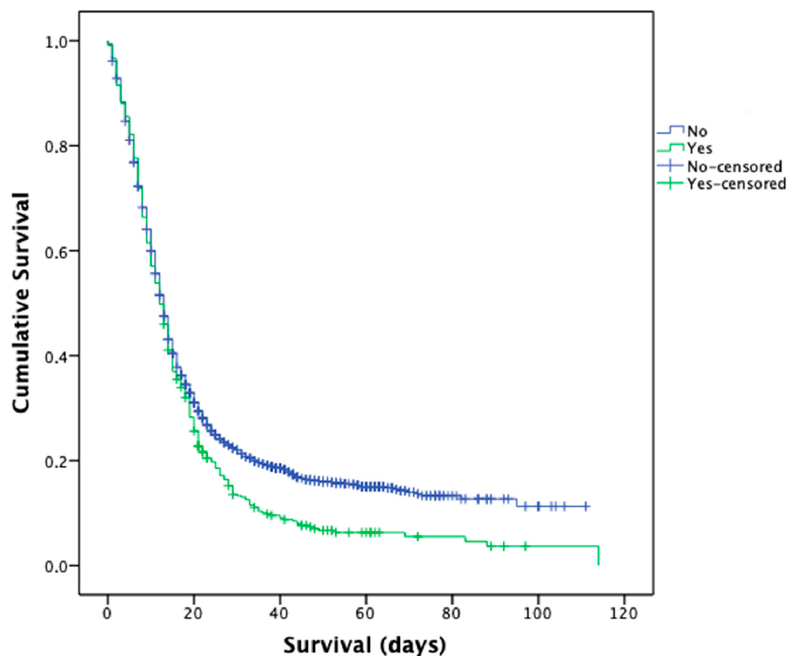
Figure 3. Kaplan–Meier survival curve for in-hospital COVID-19 patients with and without severe acute respiratory syndrome in Castile and Leon (Spain) (1 March–31 May 2020). acute respiratory syndrome in Castile and Leon (Spain) (1 March–31 May